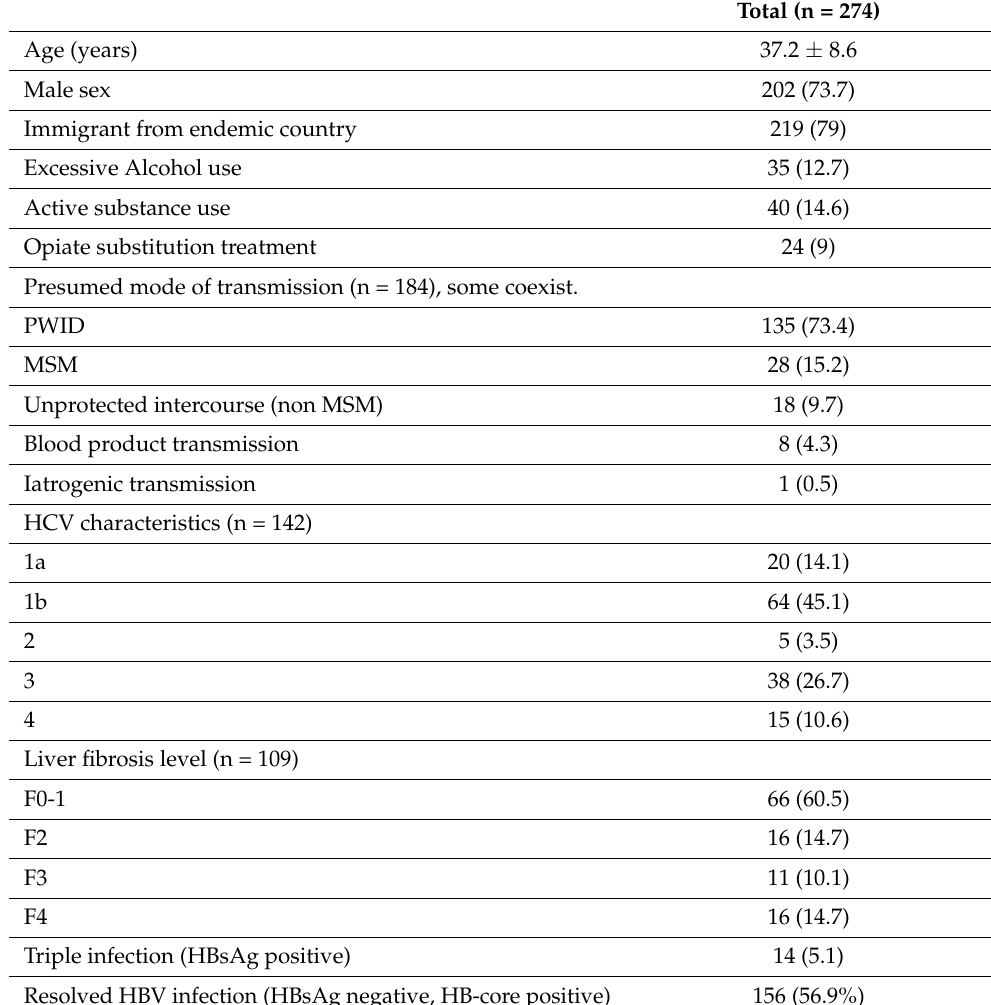
Table 1. Basic characteristics of the study